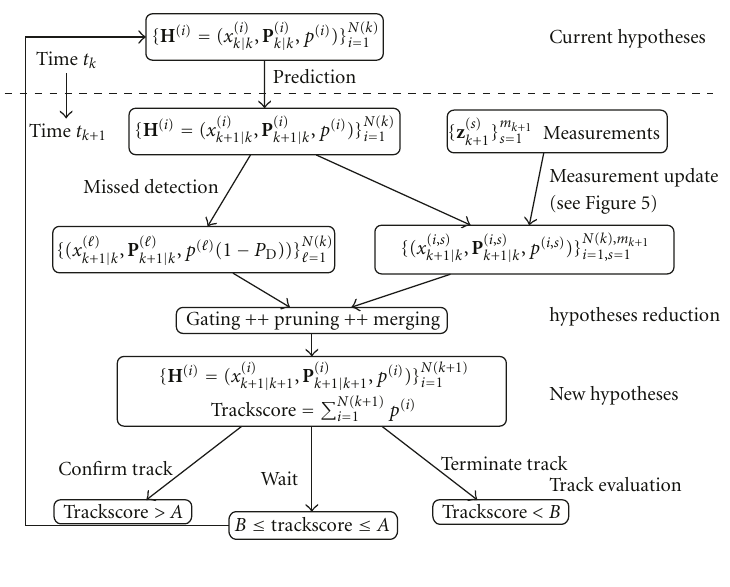
Figure 6: One cycle of the MHT: prediction of hypotheses; update of hypotheses; hypotheses reduction (by gating, pruning, and merging); track confirmation or